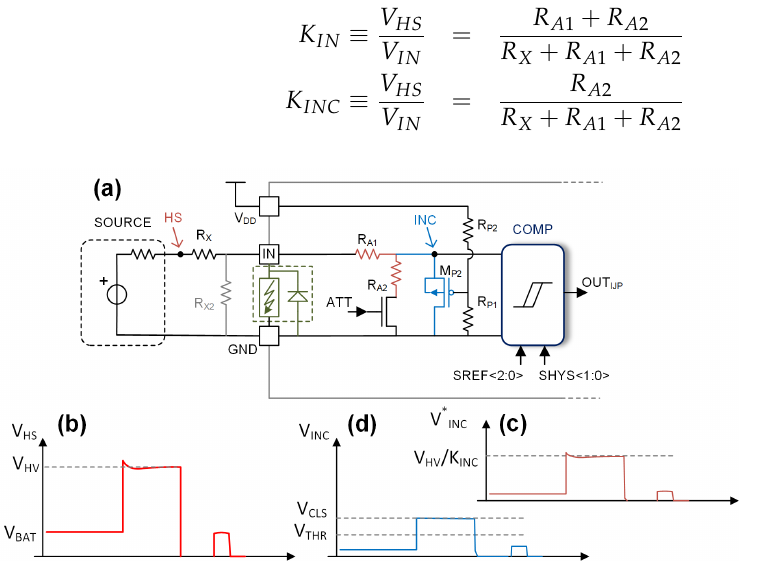
Figure 6. ( a ): Interface and readout circuit for the signal at the injector high-side pin (GDI case). ( b ): Input signal. ( c ): Signal at the comparator input without the PMOS clamp. ( d ): Signal at the comparator input with the PMOS